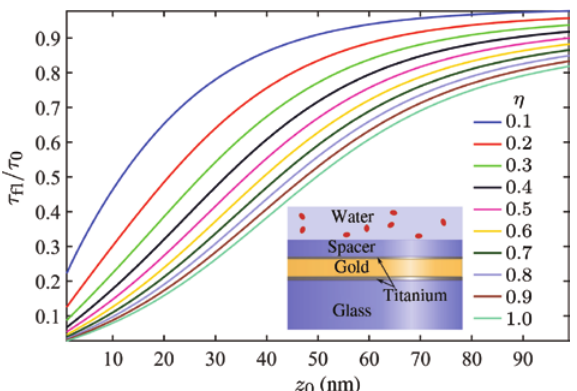
Figure 2: Exemplary MIET